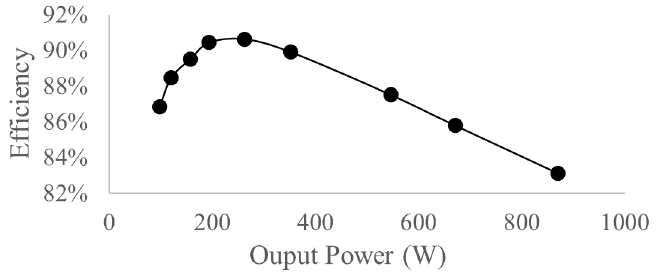
Figure 33. Efficiency at different power levels. Table 3. Power loss distribution at the maximum output